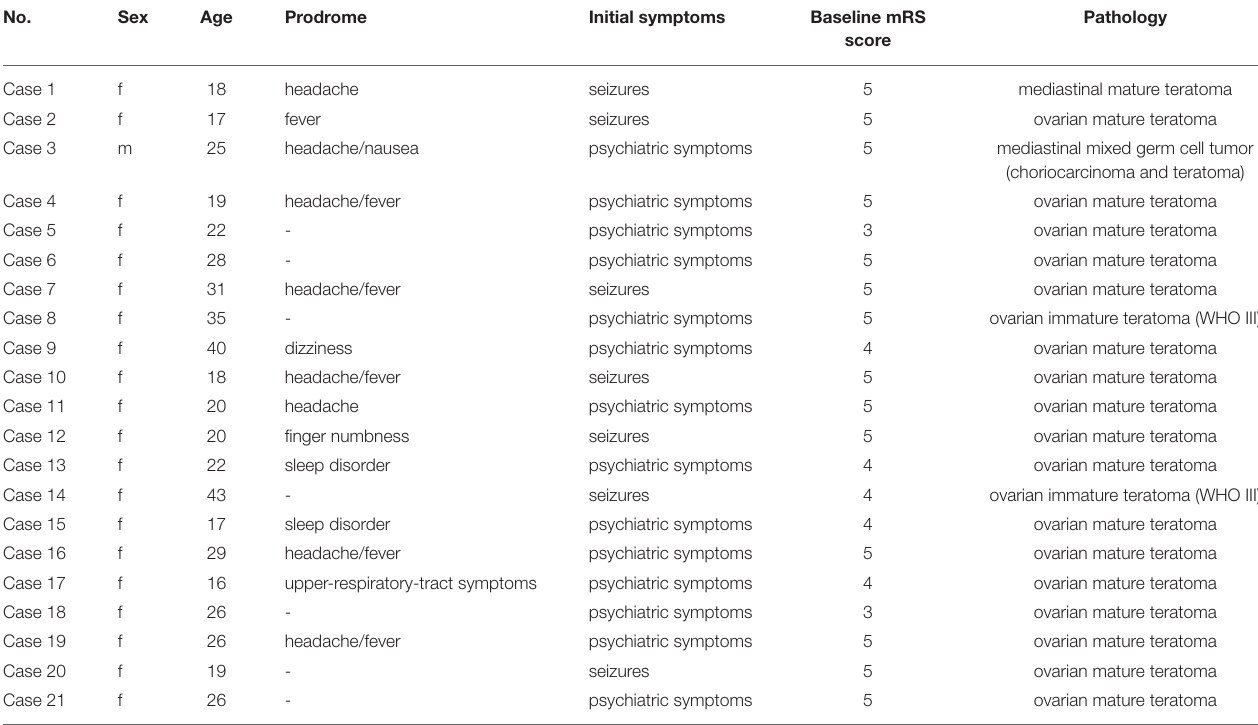
TABLE 2 | Clinical features of patients with